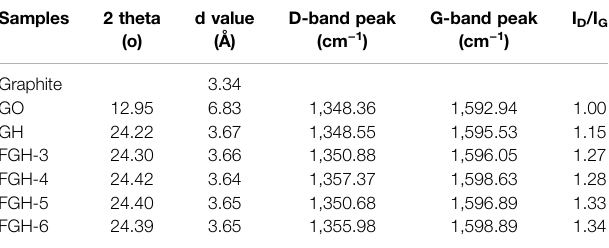
TABLE 2 | XRD and Raman spectral data for the samples.